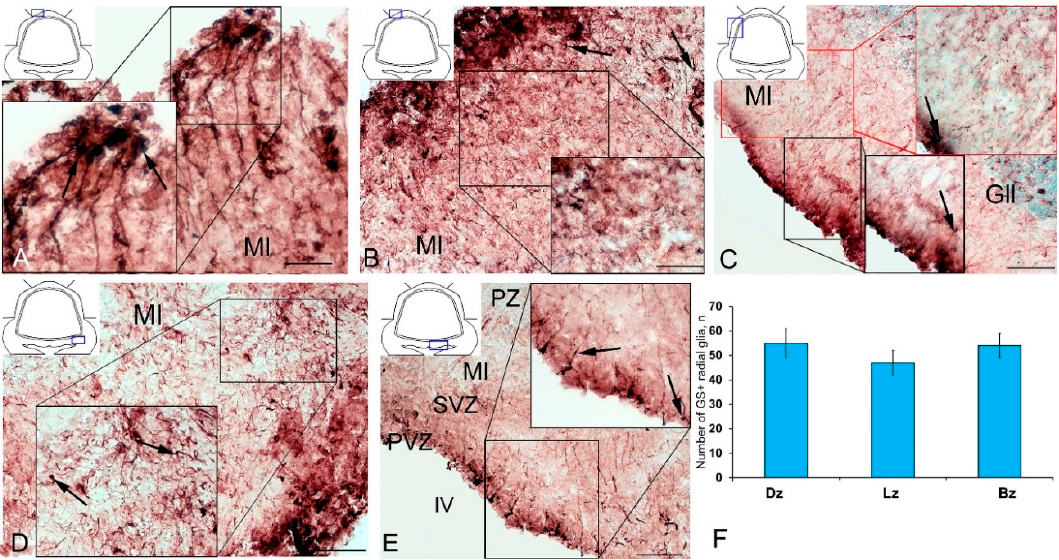
Figure 7. Radial glia (RG) in the intact cerebellum of juvenile masu salmon, Oncorhynchus masou . ( A ) DZ of rostral cerebellum: aggregation of GS+ RG cells (black inset); RG cells (black arrows); molecular layer (Ml). ( B ) DZ of caudal cerebellum. ( C ) LZ: GS+ RG cells in the PVZ molecular layer (red arrows); ganglionic layer (Gll). ( D ) BZ in the rostral part of the cerebellum. ( E ) BZ in the caudal part of the cerebellum, periventricular zone (PVZ), subventricular zone (SVZ), parenchymal zone (PZ). ( F ) The number of RGs in the intact cerebellum of juvenile O. masou . The cerebellar zones of juvenile O. masou are plotted on the X-axis. Dz, dorsal zone; Lz, lateral zone; Bz, basal zone; Ml, molecular layer; Grl, granular layer; IV, fourth ventricle. IHC labeling with GS. The blue rectangle in the pictogram indicates the corresponding area in the micrograph. Scale bars: ( A – E ) 100 μ m.